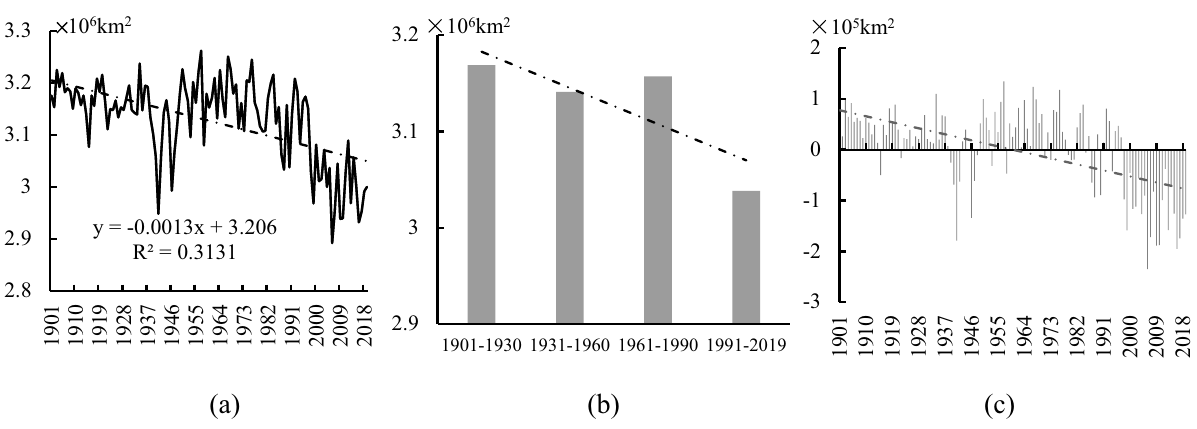
Figure 5. ( a ) Interannual and ( b ) tri-decadal variations and ( c ) anomalies in the spatial extent of the cold regions in the Qinghai-Tibetan Plateau from 1901 to